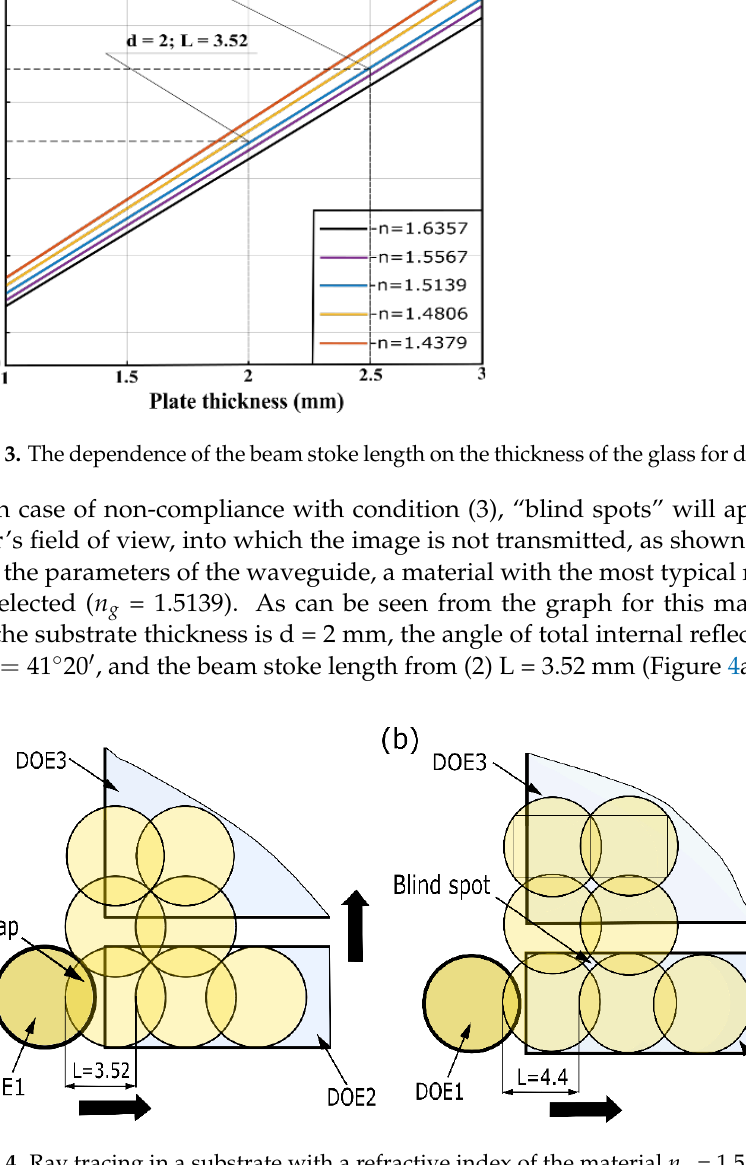
Figure 4. Ray tracing in a substrate with a refractive index of the material 𝑛 𝑔 = 1.5139. ( a ) Substrate thickness d = 2 mm. ( b ) Substrate thickness d = 2.5 mm.